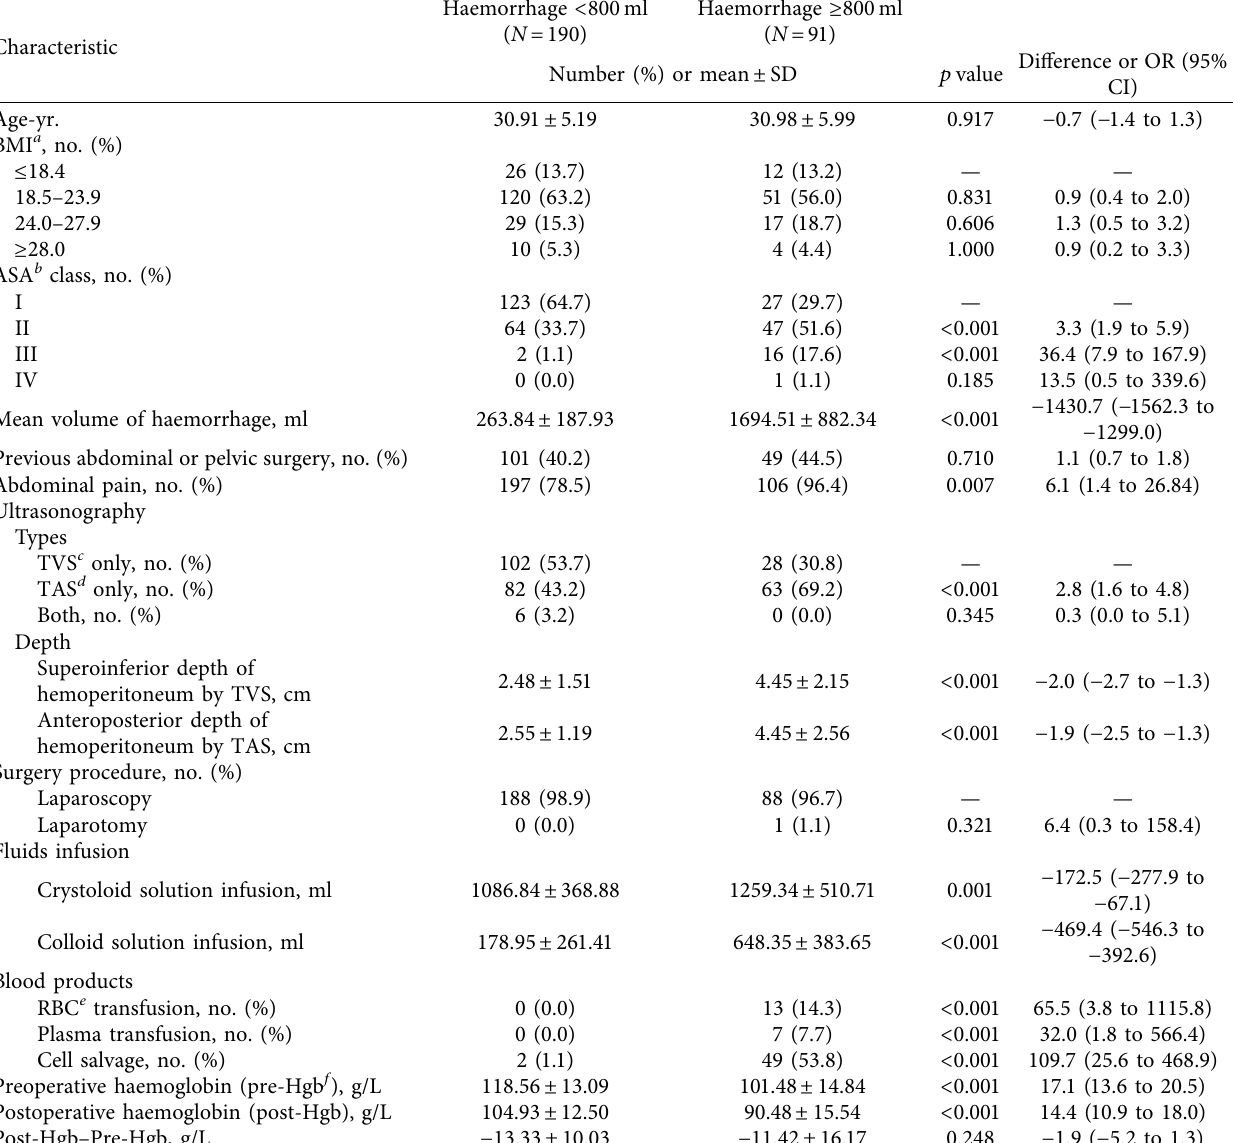
Table 1: Clinical characteristics of the ectopic pregnancy